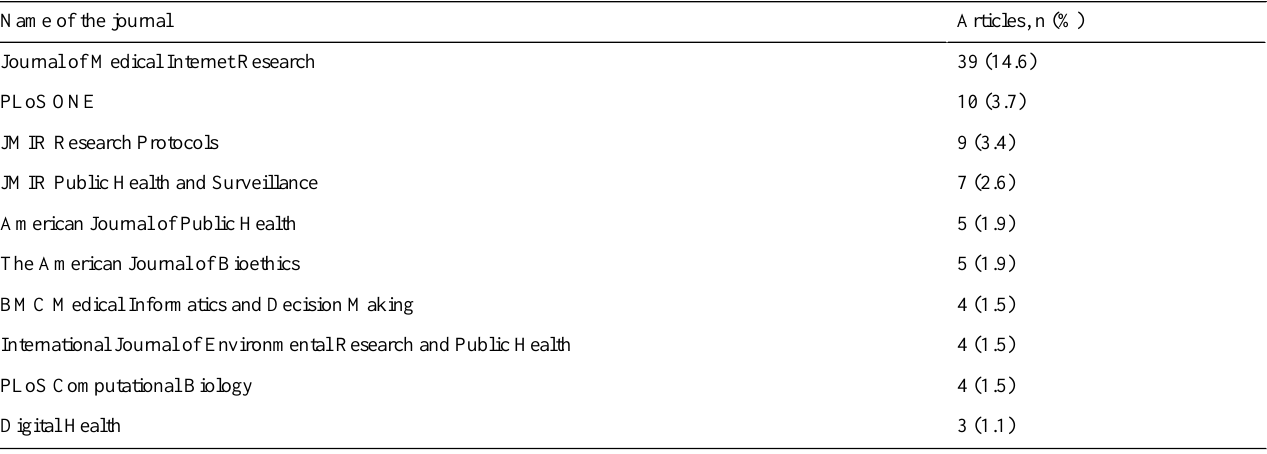
Table 1. Top 10 most common journals publishing work using social media for health research purposes.